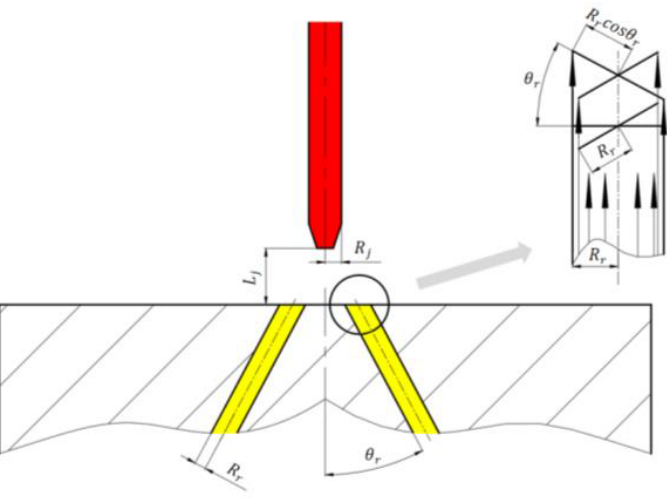
Figure 3. Projection relationship between the hole and the upper surface of the receiver. A Cartesian coordinate system is created with O 1 as the origin in Figure 2. When the jet pipe shifts to the right by ∆ x, the flow area of the right receiving hole is shown in Figure 4.